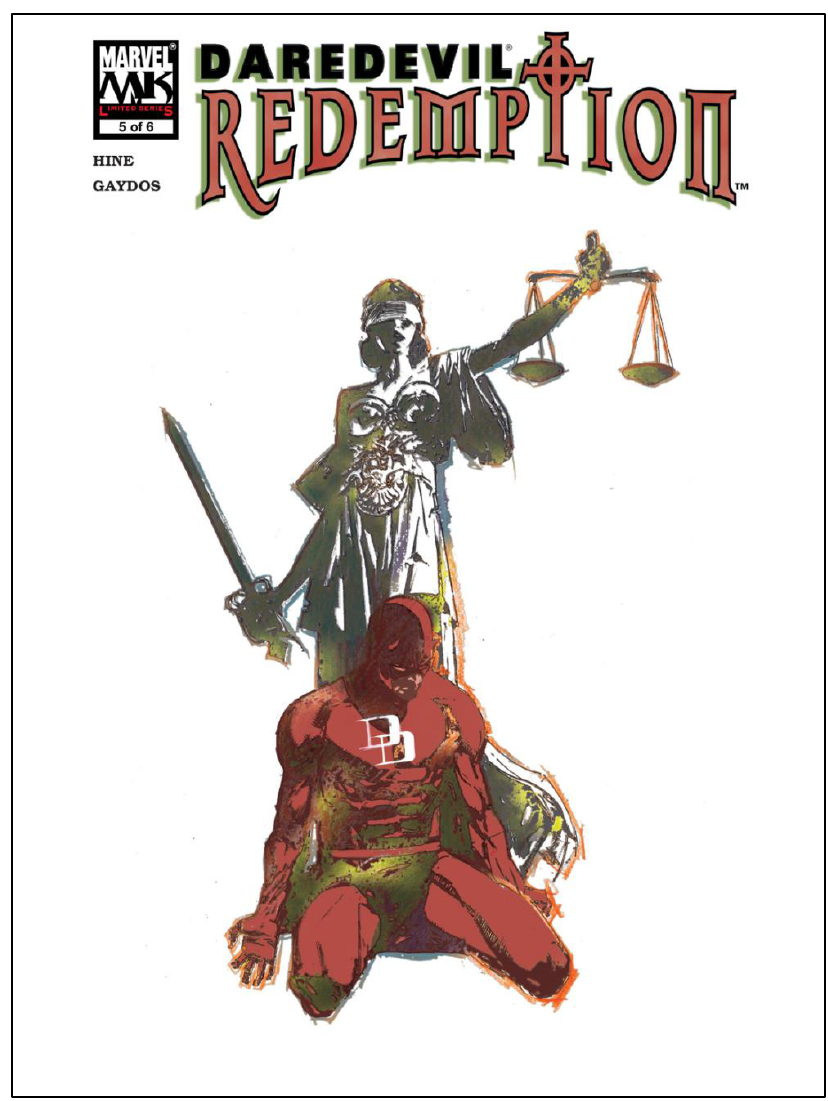
Figure 1. Cover from Hine Daredevil: Redemption #5,